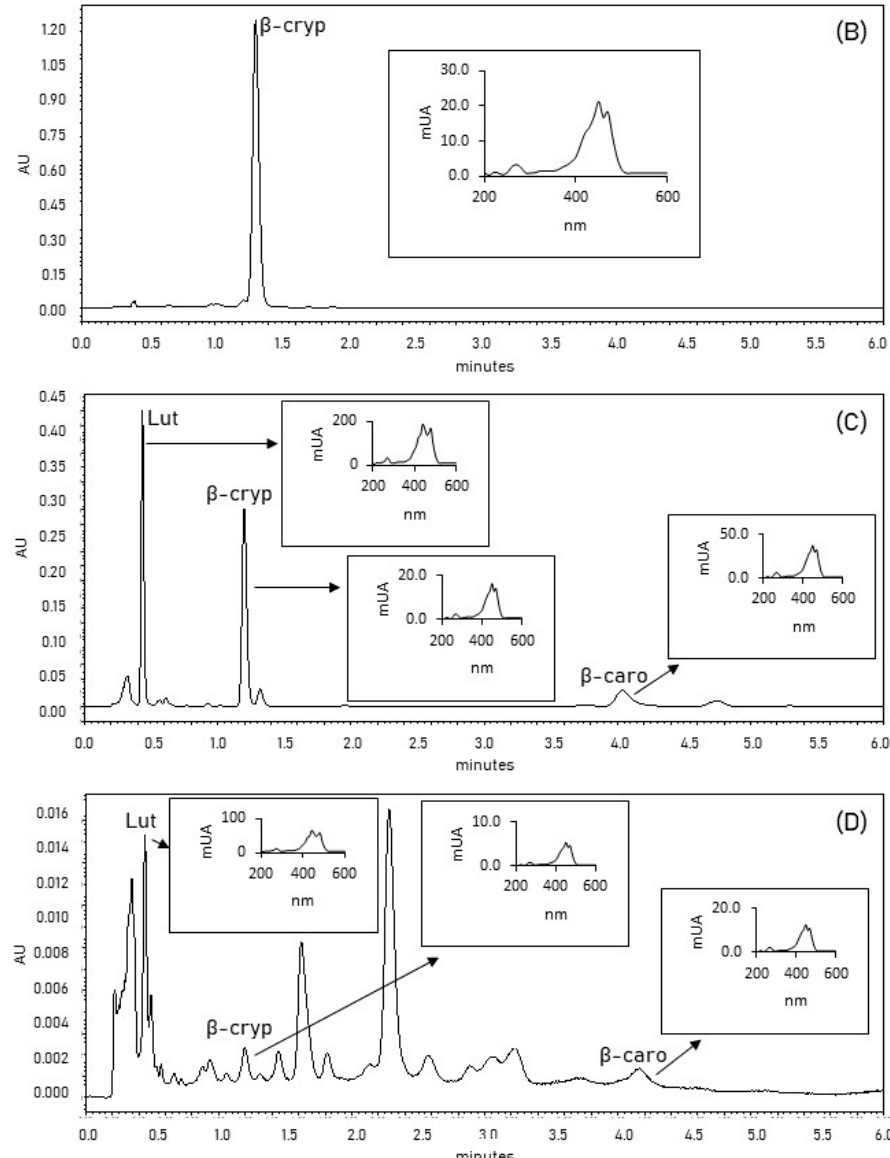
Figure A1. Chromatograms of carotenoids at 475 nm: lutein (Lut), β -carotene ( β -caro) and β -cryptoxanthin ( β -cryp). ( A ) Standards of lutein and β -carotene. ( B ) Standard of β -cryptoxanthin. ( C ) Extracted from unripe (color green) Habanero pepper grown in red soil and harvested at 334 PTD. ( D ). Extracted from ripe Habanero pepper grown in red soil and harvested at 334 PTD. Extraction method: 500 mg of Habanero pepper with 2.5 mL of ethanol was sonicated at 42 KHz for 20 min and then, centrifuged at 3500 rpm for 30 min and filtered through a 0.2 µm PTFE filters.